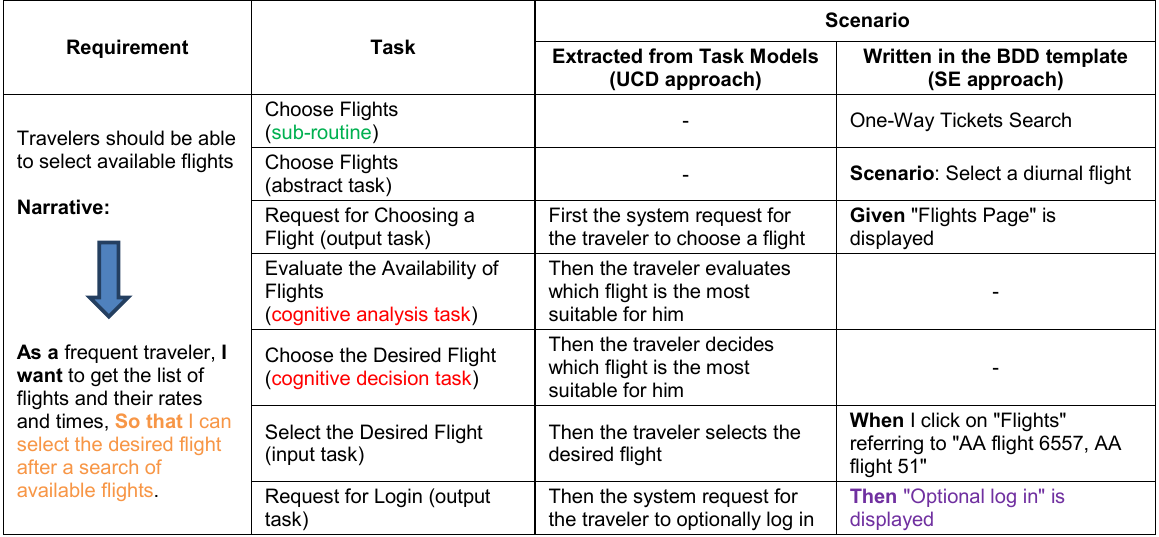
Table 4. The correlation between Requirements, Tasks and Scenarios in UCD and SE approaches for the User Story “Select the desired